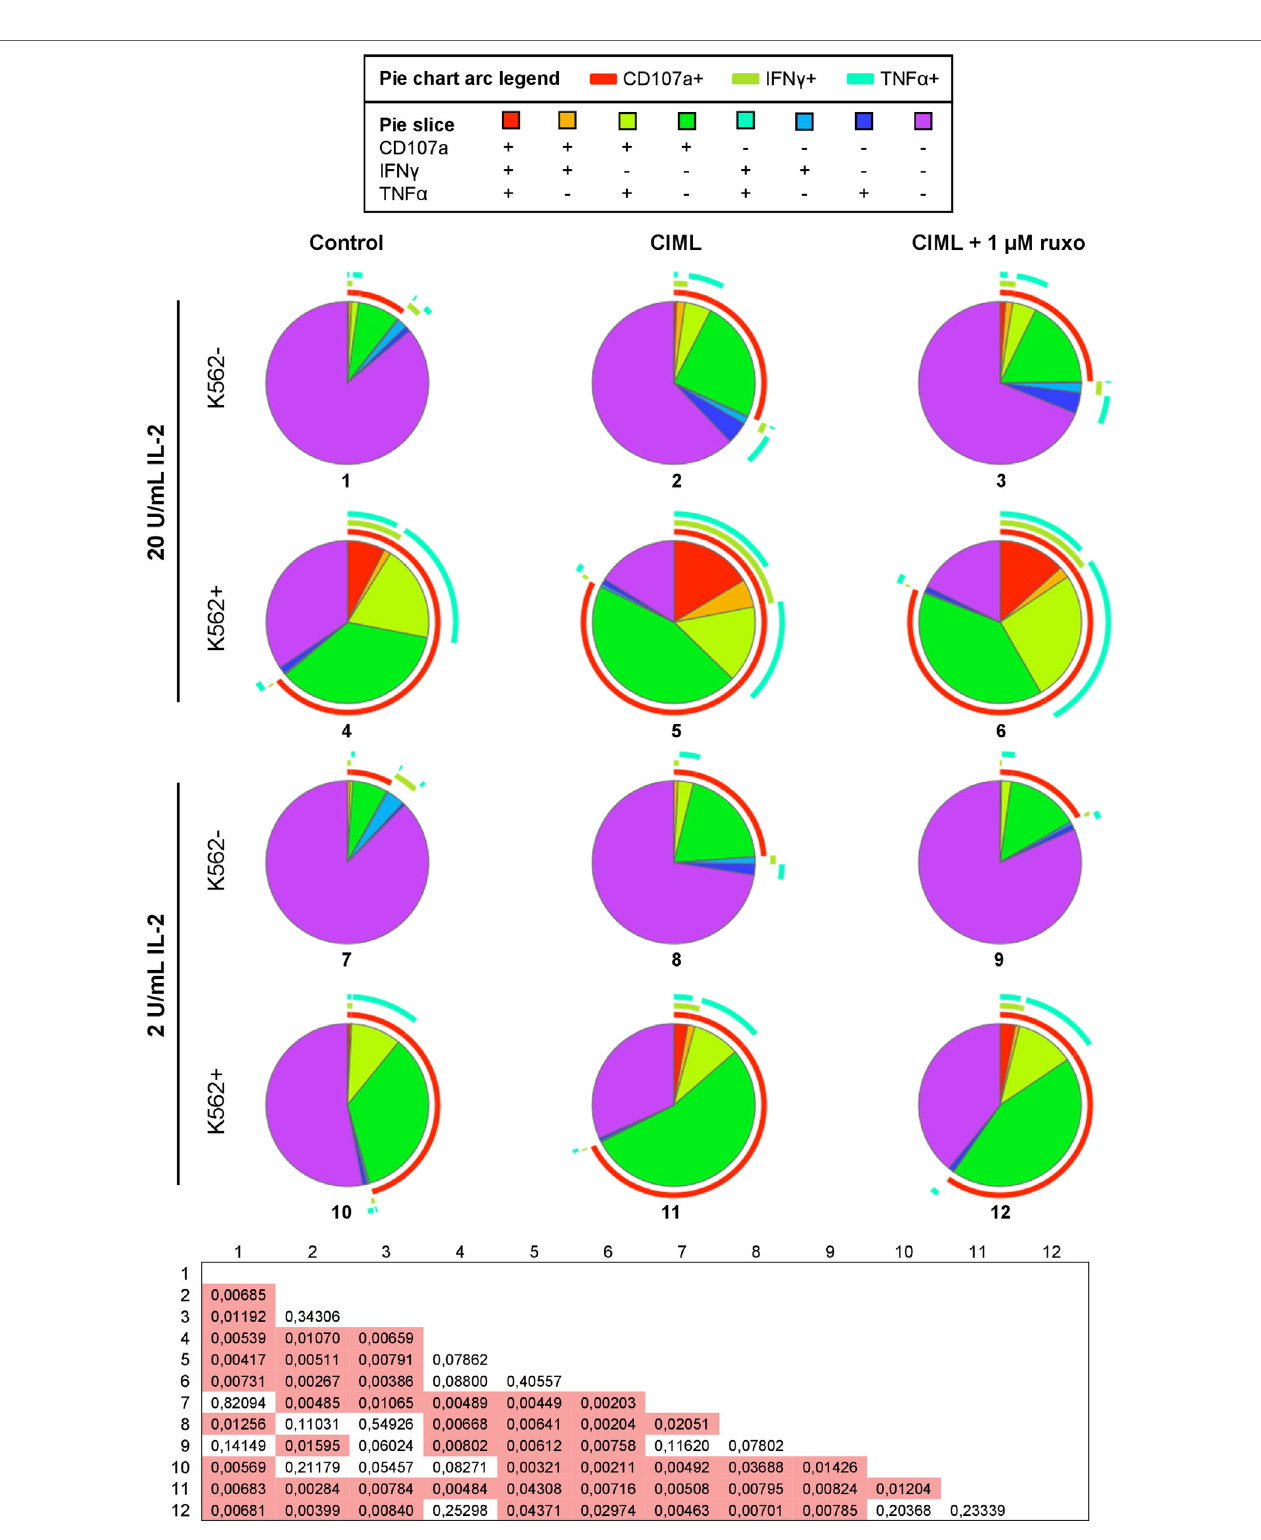
FigUre 6 | Polyfunctionality of cytokine-induced memory-like (CIML) natural killer (NK) cells after the expansion phase. Pie charts represent the percentages of control non-preactivated and CIML NK cells, preactivated in the presence and absence of 1 µM ruxolitinib, expressing CD107a, IFN γ , and/or TNF α . Cells were exposed to 2 U/mL (lower six pie charts) or 20 U/mL (upper six pie charts) of IL-2 during the expansion phase of 4 days, and then washed and incubated with or without K562 cells for 6 h ( n = 6). Differences between pie charts were established with non-parametric permutation test. The p values are in the box below the pie charts. Significant differences are in the red